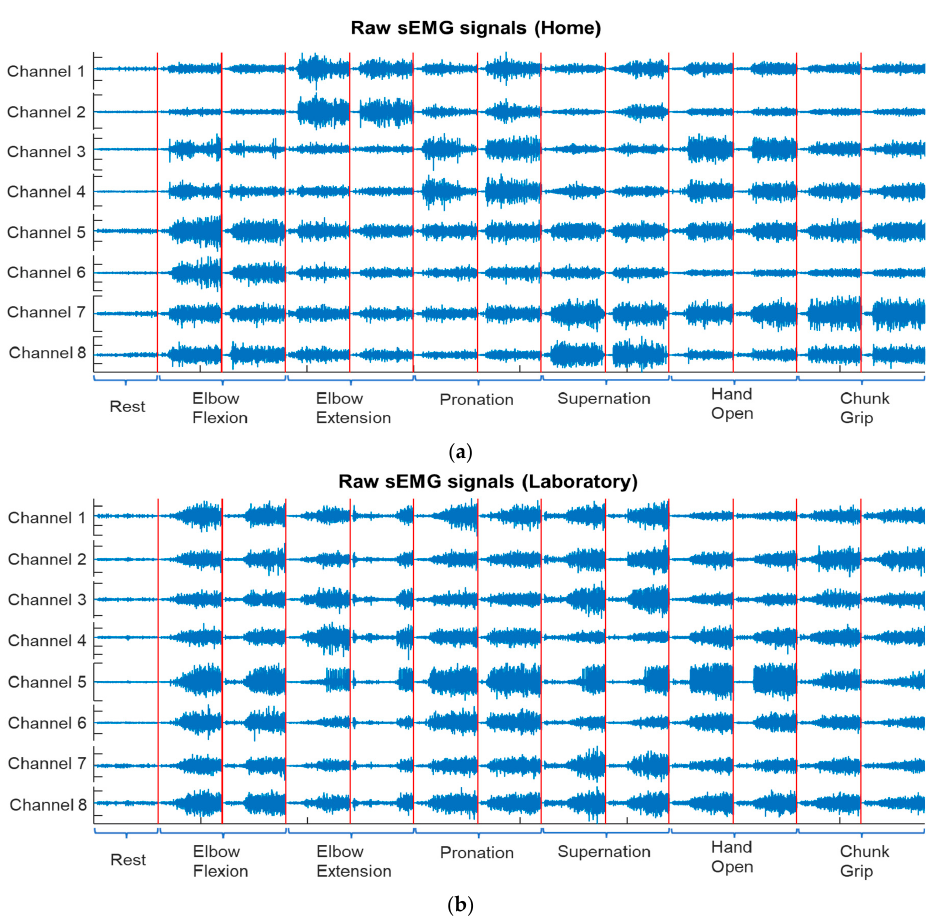
Figure 1. An example of TH02’s calibration data with all seven motions ( a ) at home and ( b ) in a laboratory setting. The red vertical lines separate different